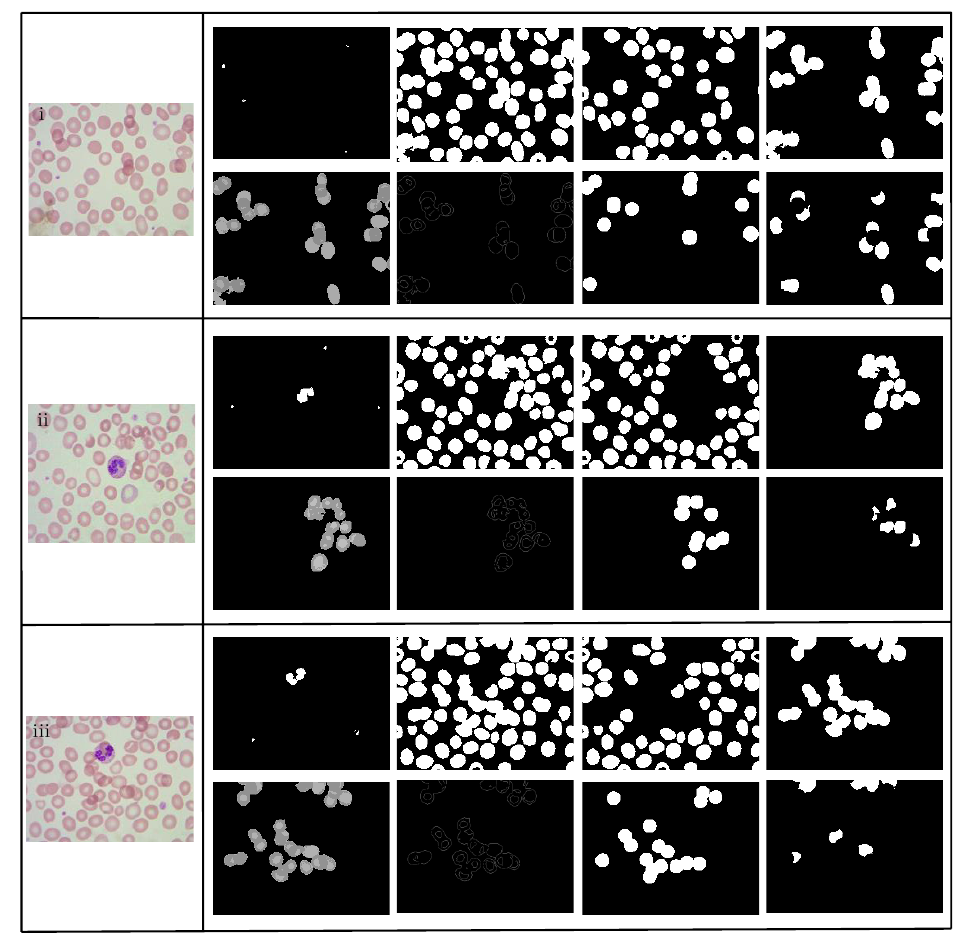
Fig. 8. Three representative experimental results. Table 2. Cells counting using proposed algorithm. surface. Runtime : Using nonoptimized computer program code on standard 2. GHz CPU, the average running time of this method was 31.04 s/image. A comparison with other methods dealing with